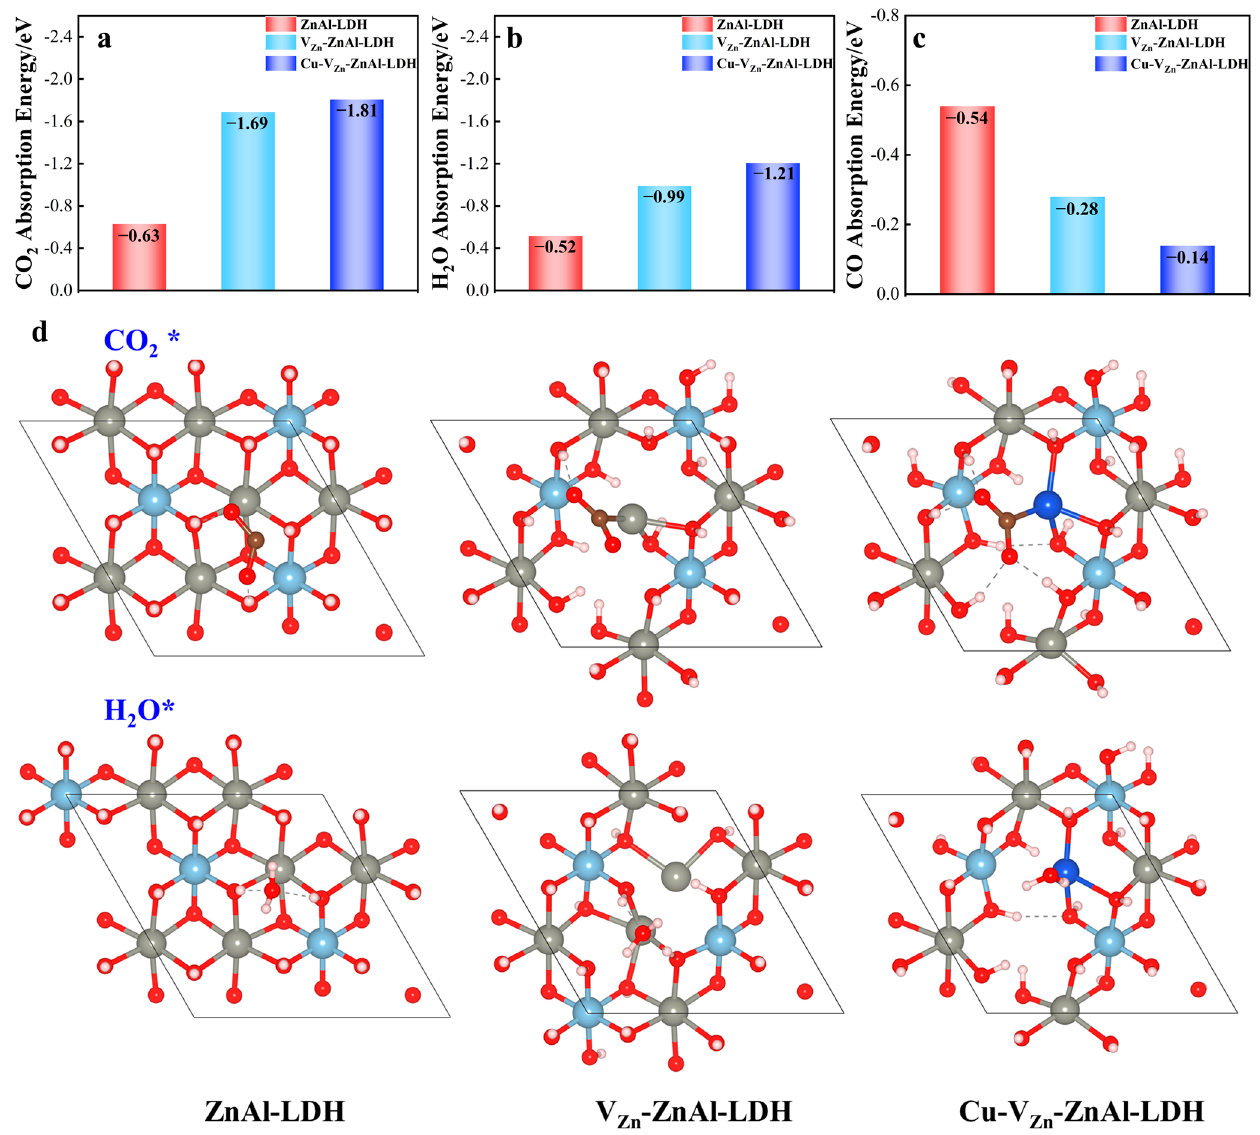
Figure 7. The adsorption energies of ( a ) CO 2 , ( b ) H 2 O, and ( c ) CO are absorbed on three ZnAl- LDHs, and ( d ) related structures for CO 2 (up) and H 2 O (down) adsorption (The “*” represents the appropriate adsorption state on the catalyst’s surface).